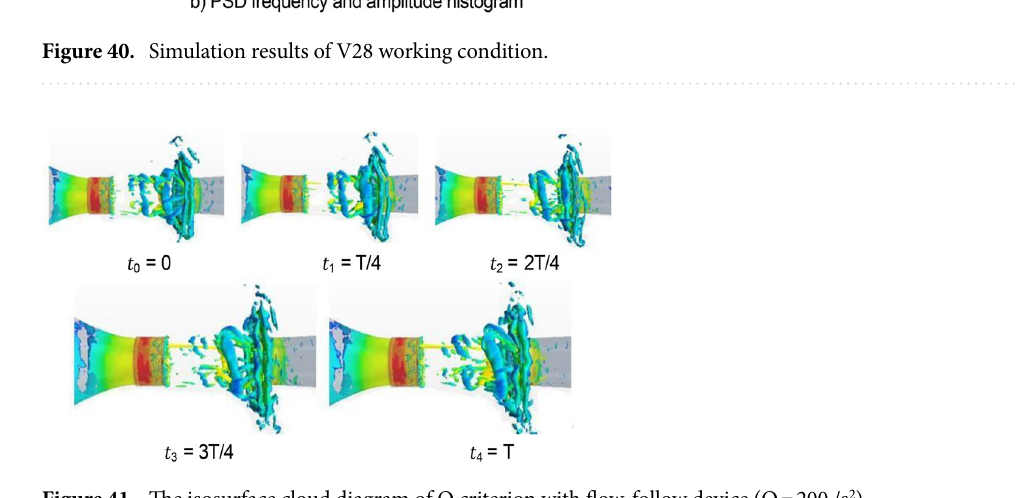
Figure 41. The isosurface cloud diagram of Q criterion with flow-follow device (Q = 200 /s 2